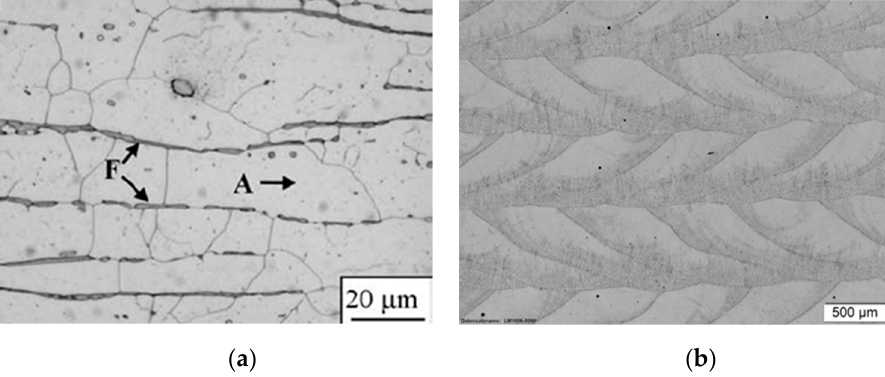
Figure 11. ( a ) Conventional annealed 316L material with ferrite (F) and austenite (A) [29]; ( b ) x – z cross section of as built 316L-Si sample placed in 45° to the scanning direction.